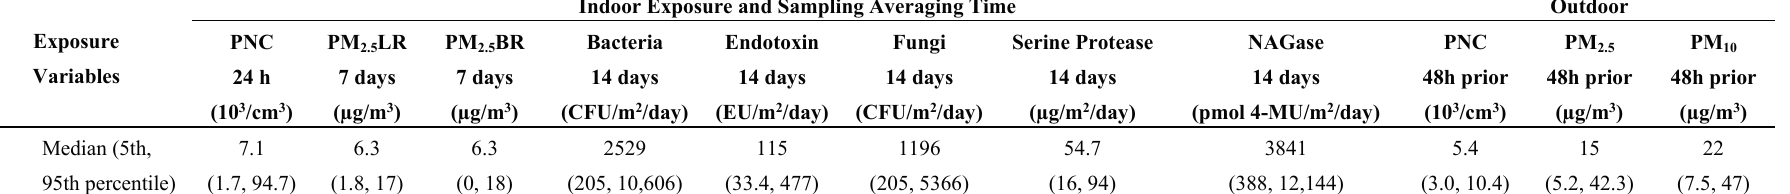
Table 3. Median (5th, 95th percentile) of all measurements and correlation coefficients ( p -values) of simultaneously measured indoor and outdoor air pollutants.